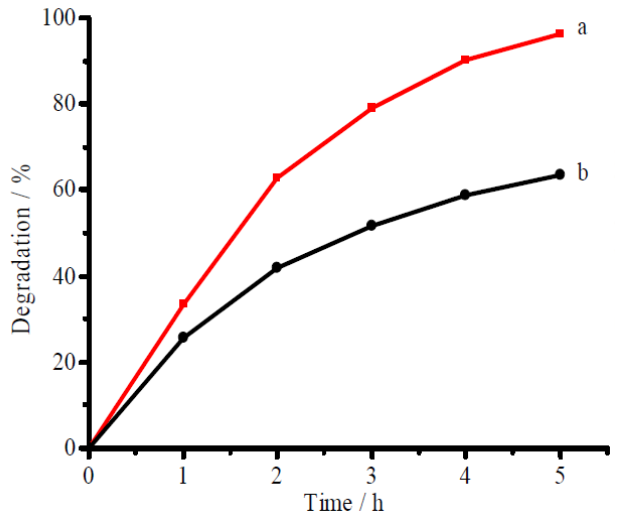
Figure 6. Photocatalytic degradation of ammonia ( a ) and RhB ( b ) in 100 mg/L ammonia-N solution alone and in 50 mg/L RhB solution alone, respectively. The CuFe 2 O 4 /NG catalyst of 0.1 g was used in 50 mL volume with pH 9.5 under visible light irradiation.